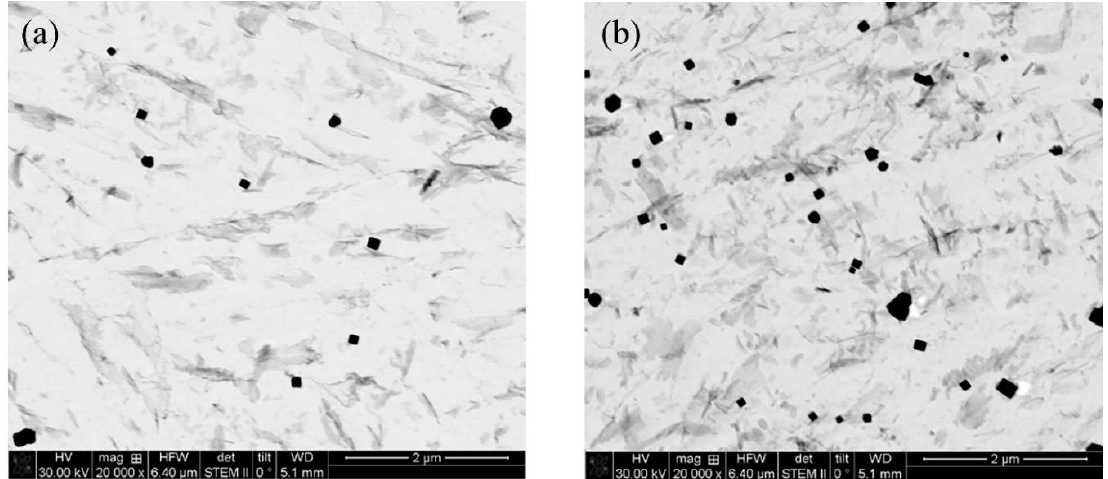
Figure 10. Comparison between distribution, number density, and shape of the particles in carbon replicas made from the sample: ( a ) S(540, 5) and ( b ) S(640, 50). From EDS measurements, it was determined that the particles in samples partitioned at 540 ◦ C and 640 ◦ C are principally MoC (round shaped particles) and Ti(C, N) (rectangular shaped